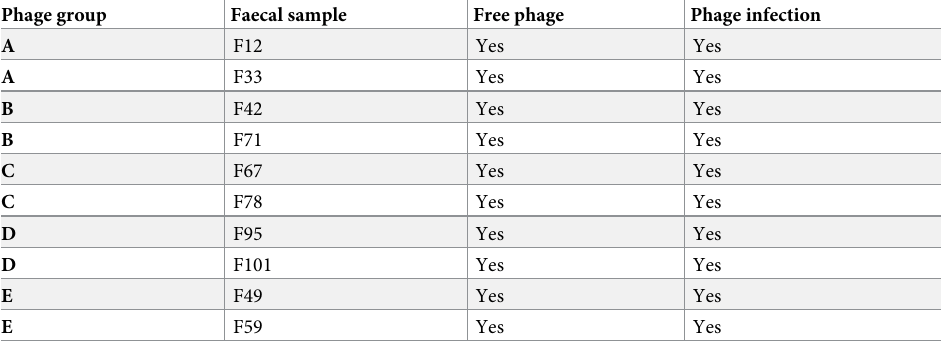
Table 2. Phage detection in individual faecal samples by phageFISH in faecal smears, free phages and advanced infection could be detected in all samples. Phage